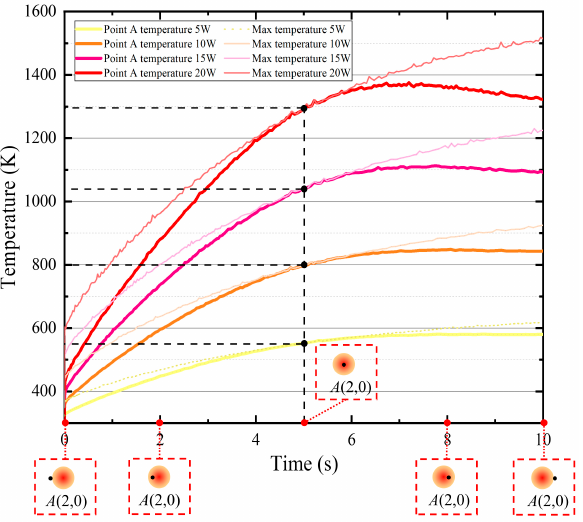
Figure 2. Historical temperature information of binderless tungsten carbide (WC) workpiece under different laser power heating.